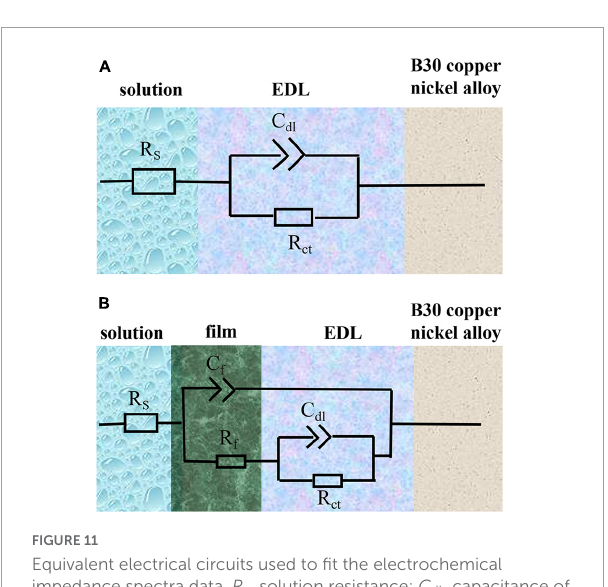
FIGURE11 Equivalent electrical circuits used to fit the electrochemical impedance spectra data. R s , solution resistance; C dl , capacitance of electric double layer (EDL); R ct , charge transfer resistance; C f